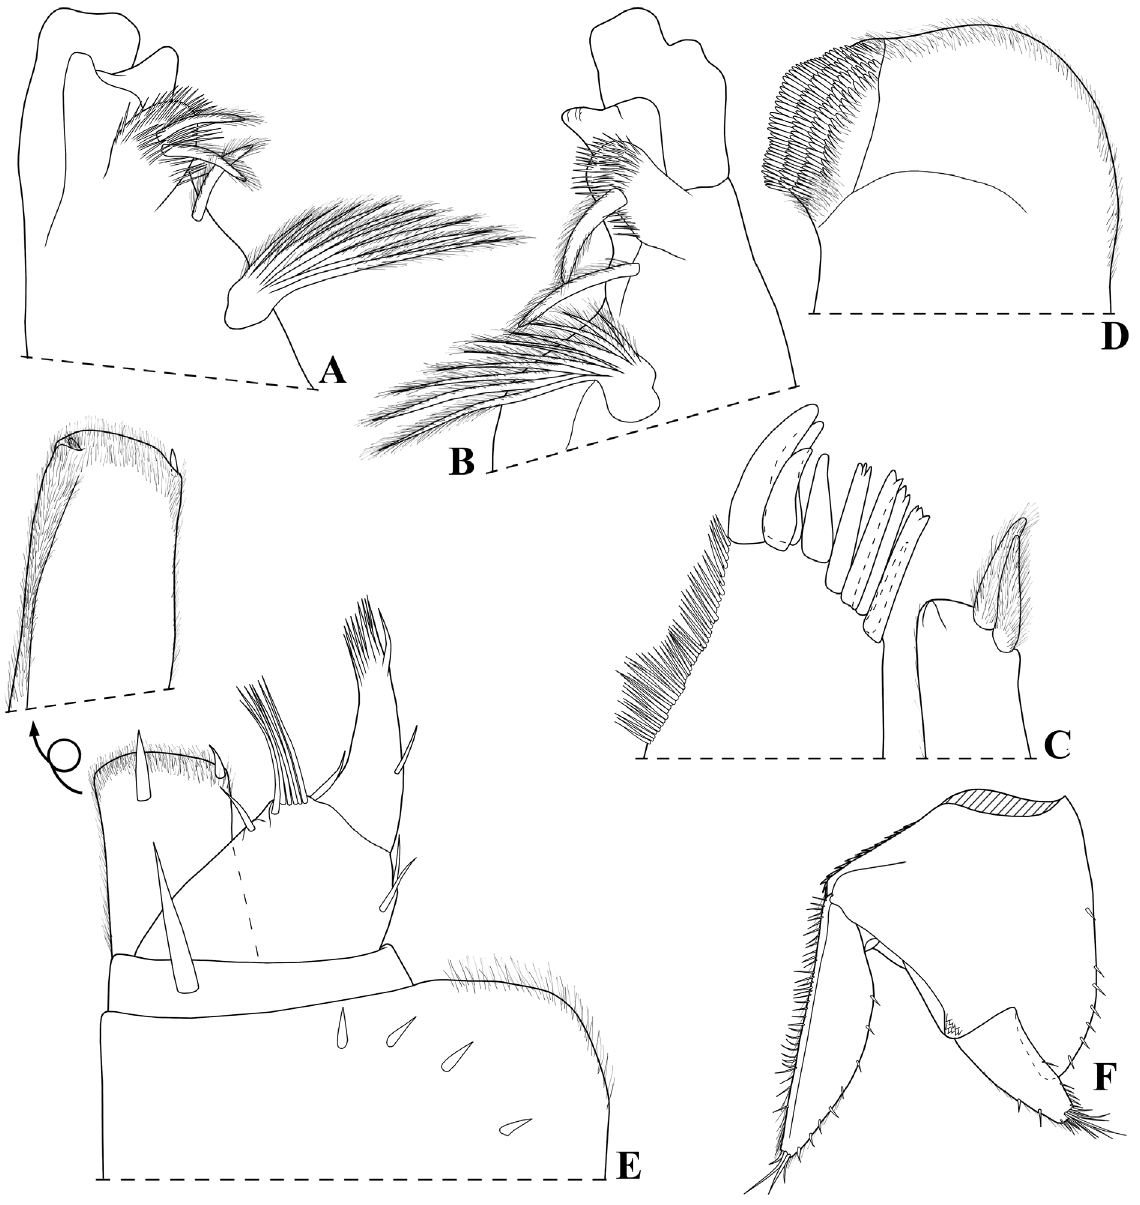
Fig. 12. Amazoniscus spica Campos-Filho, Aguiar & Taiti sp. nov., ♀, paratype (MZUSP 40047). A . Left mandible. B . Right mandible. C . Maxillula. D . Maxilla. E . Maxilliped. F .